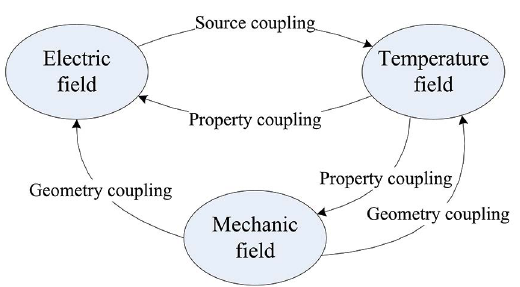
Figure 5: Schematic diagram of coupling relationship between temperature field, electric field and mechanic field. between electric field and temperature field as well as the coupling relationship between temperature field and mechanic field is interacted, while the electric field is unidirectionally coupled with the mechanic field. As a result, the electrical- thermal-mechanical coupling analysis (Joule-mechanical) can be regarded as a combination of electrical-thermal analysis (Joule heating) and thermal-mechanical